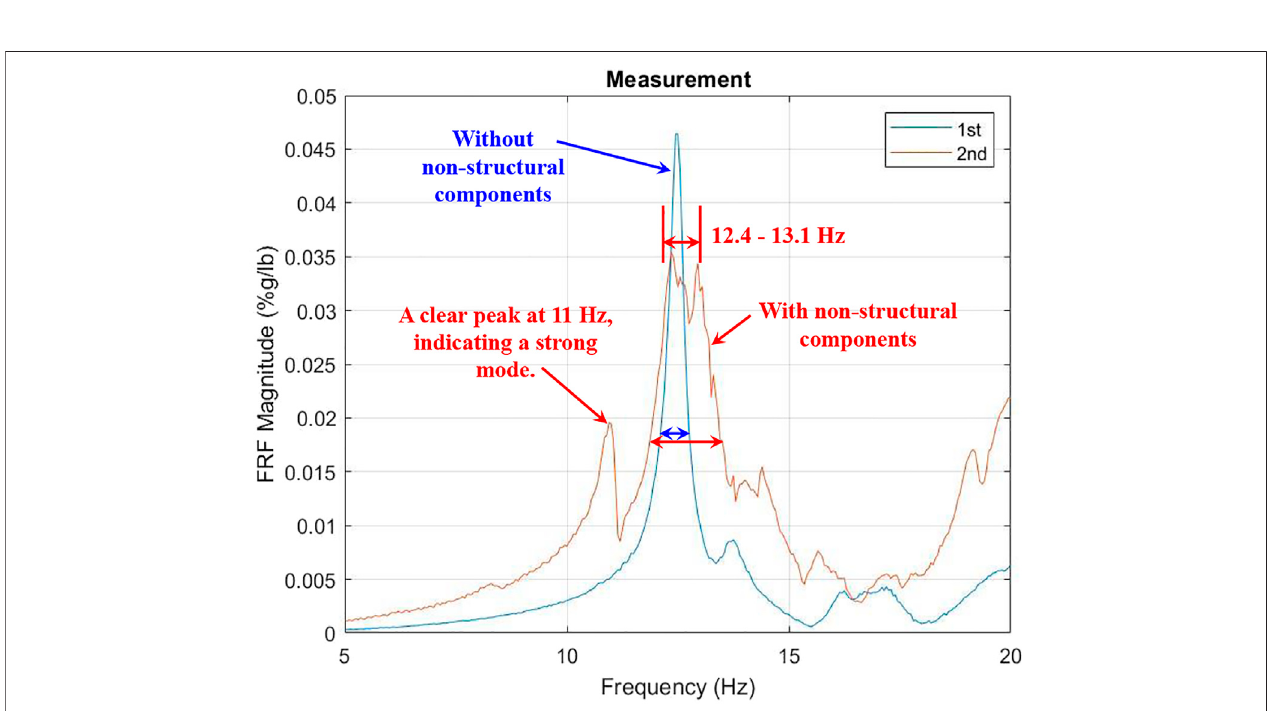
FIGURE 11 | Comparison of measured FRFs at Location 12: “ pre-installation of non-structural components ” vs. “ post-installation of non-structural components. ”